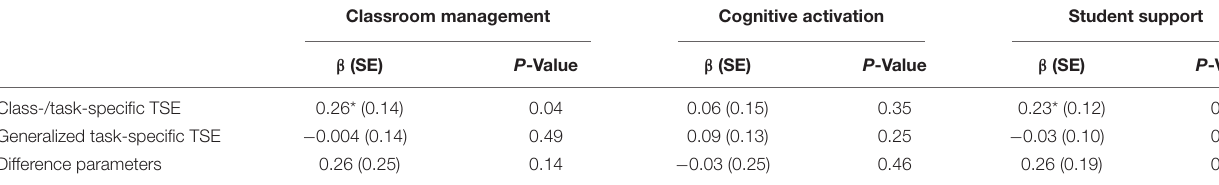
TABLE 2 | Multilevel path analysis to estimate the associations of the two TSE scales and teaching quality